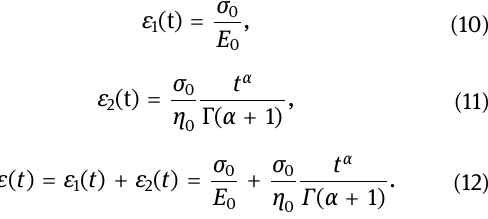
Figure 13: Fitting results based on the fractional de fi ned Maxwell model and 20% stress level.